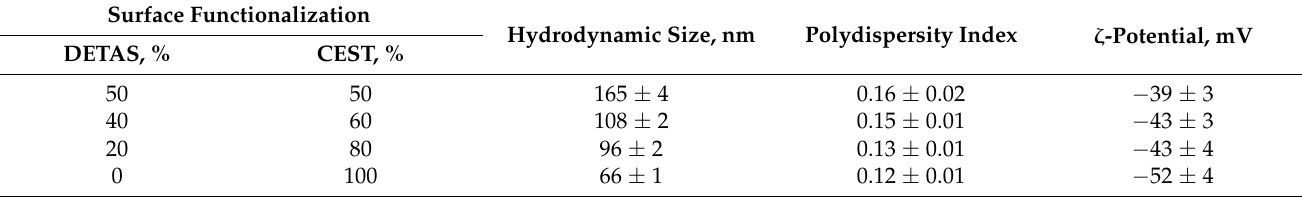
Table 1. The hydrodynamic size, polydispersity index, and ζ -potential of modified by DETAS/CEST silica